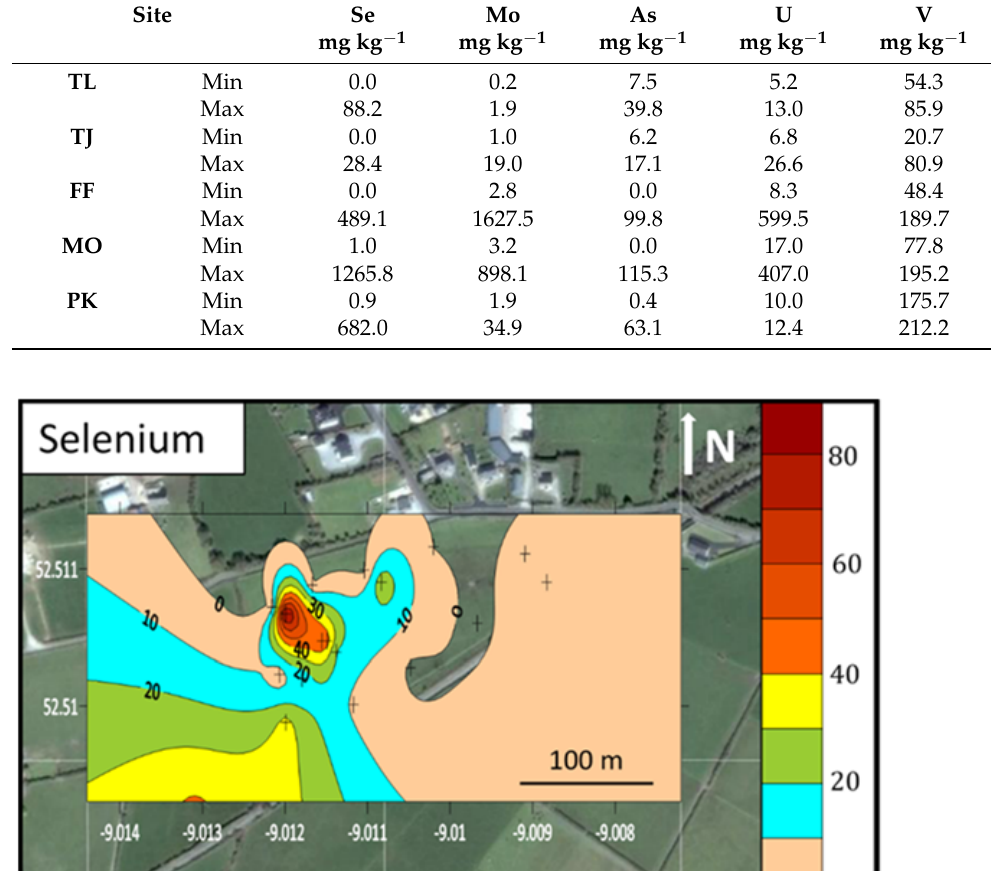
Table 1. The maximum and minimum concentrations of key elements derived from bulk samples collected at 10–20 cm depth from five agricultural sites in West Limerick, determined by XRF.